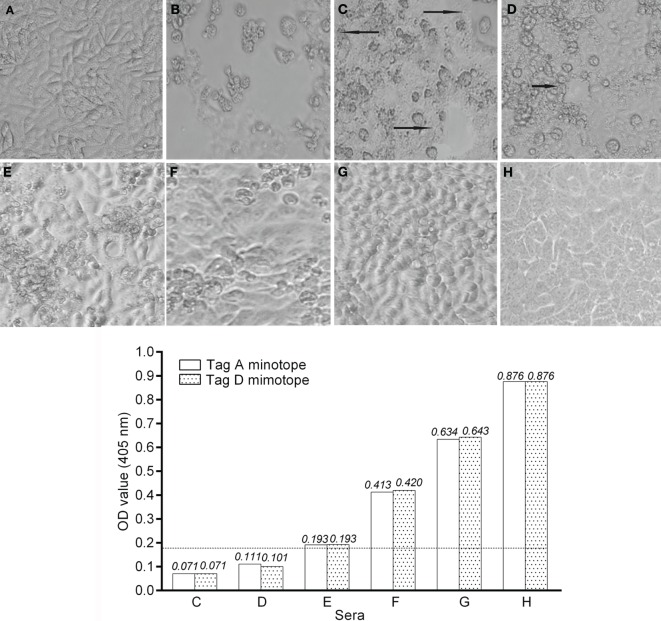
Inhibition of Simian virus 40 (SV40) cytopathic effect (CPE) in CV-1 infected cells by human immune sera. Inhibition of SV40 CPE in infected cells by human serum samples from pregnant women and non-pregnant women. Upper panel. (A) Negative control represented by uninfected CV-1 cells. (B) Positive control represented by the CPE induced by SV40 in CV-1 infected cells. (C,D) These sera did not inhibit SV40 CPE. (E–G) SV40-positive sera inhibited SV40 CPE with different degrees. (H) This serum sample completely inhibited SV40 CPE. Sample H had an optical density (OD) of 0.876 for the LT mimotopes. Bottom panel: there was a correlation between the OD values and CPE inhibition activity of tested immune sera. Indeed, serum samples C and D that were under the cutoff value did not inhibited SV40 CPE, while sera E, F, and G with an OD in the range of 0.193–0.643 inhibited partially with a different degree SV40 CPE. The serum in H panel, with the higher OD value, inhibited completely SV40 CPE.